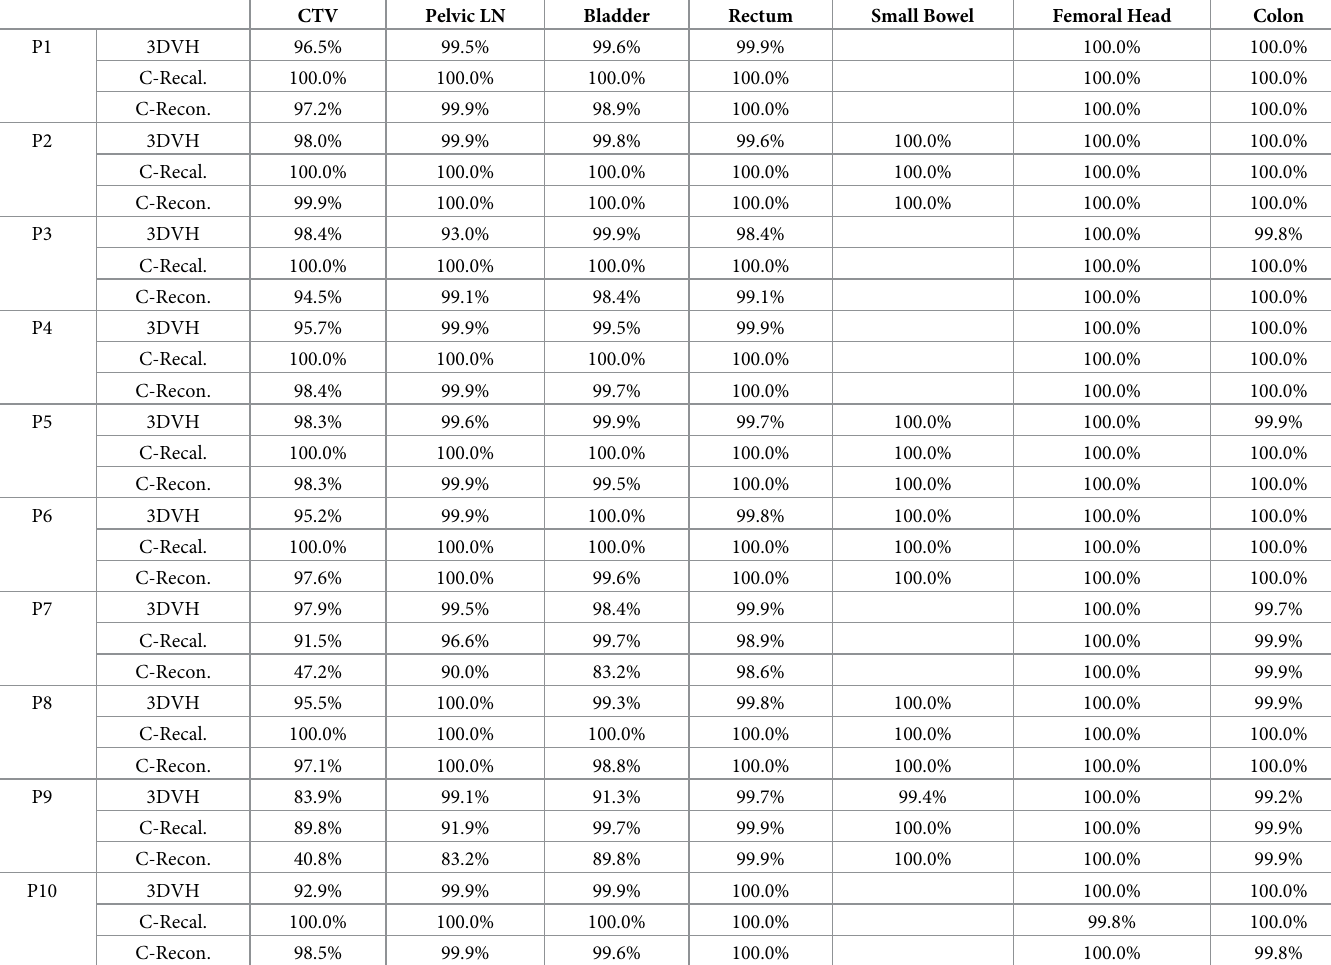
Table 5. Pass rates calculated for the gamma evaluation in the tumor target and OARs compared with a reference TPS dose with the calculated dose in 3DVH and compass (C-Recal.: Compass Recalculation, C-Recon.: Compass Reconstruction) for the Prostate